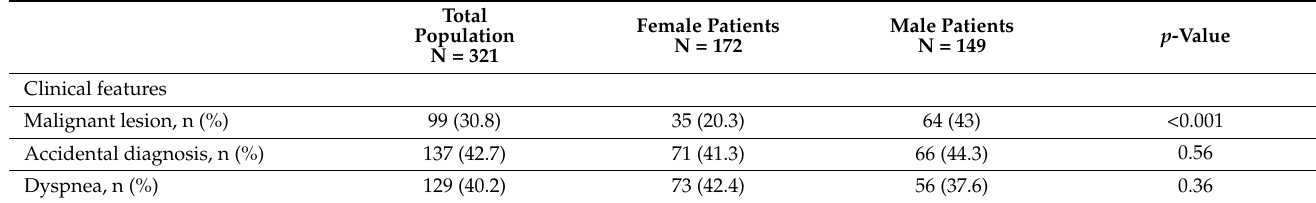
Table 2. Comparison of clinical features, laboratory results and mass location between female and male patients with cardiac